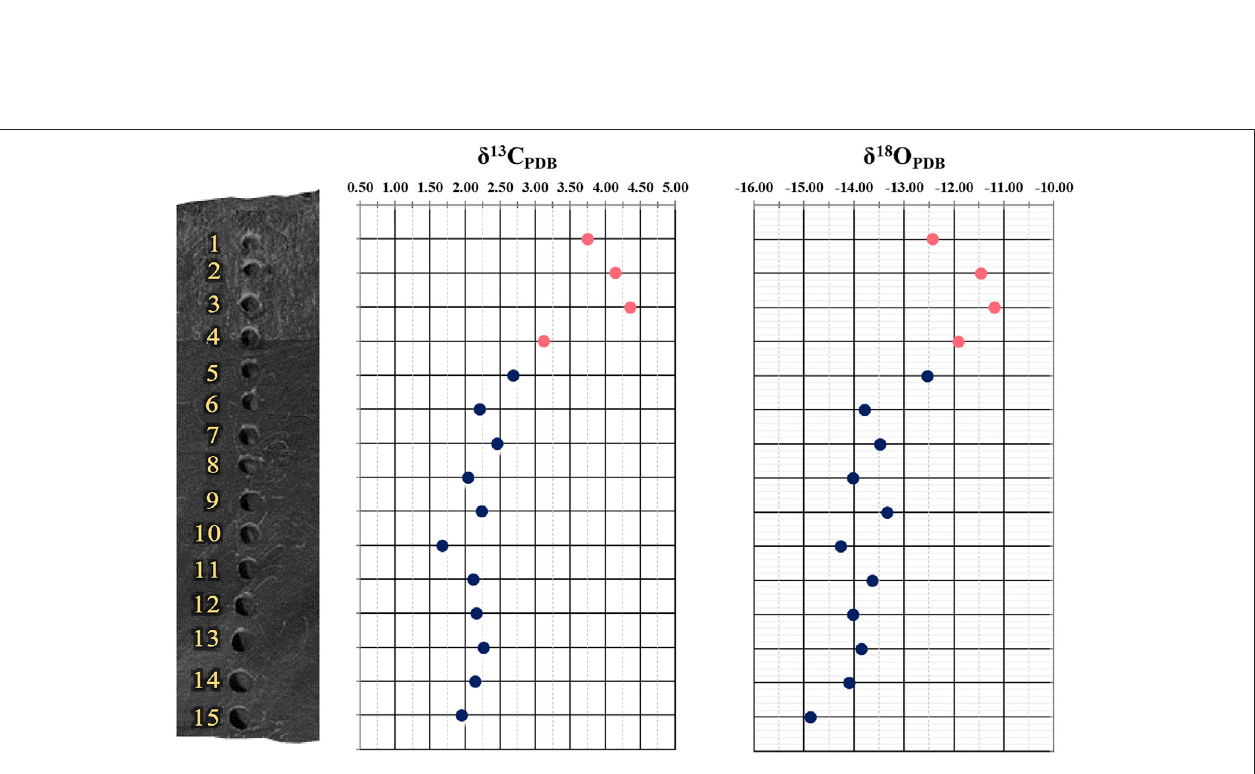
Frontiers in Earth Science |